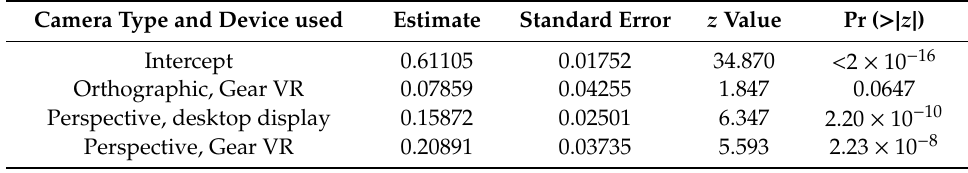
Table 16. Logistic regression results analysis by pairing the camera type and the device used.